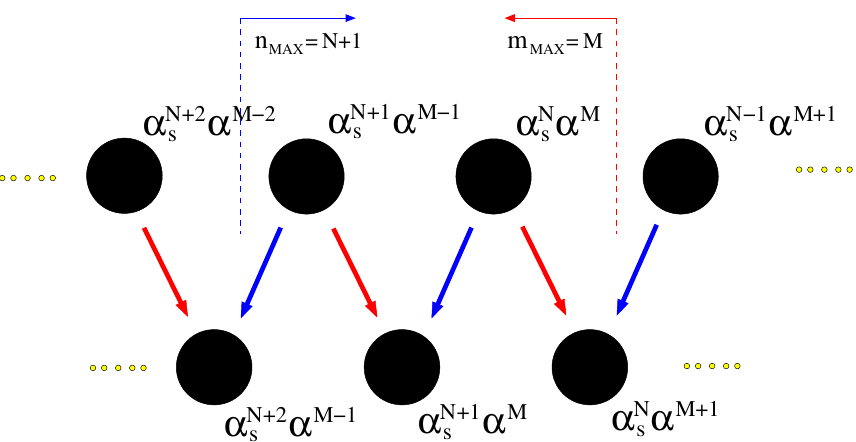
Figure 15. Example of QCD (blue, right-to-left arrows) and QED (red, left-to-right arrows) corrections to a generic process. The small yellow circles indicate the possible presence of further cross section contributions. The parameters n and m can be freely changed in order to select max max di(cid:11)erent Born contributions w.r.t. those depicted here. See the text for